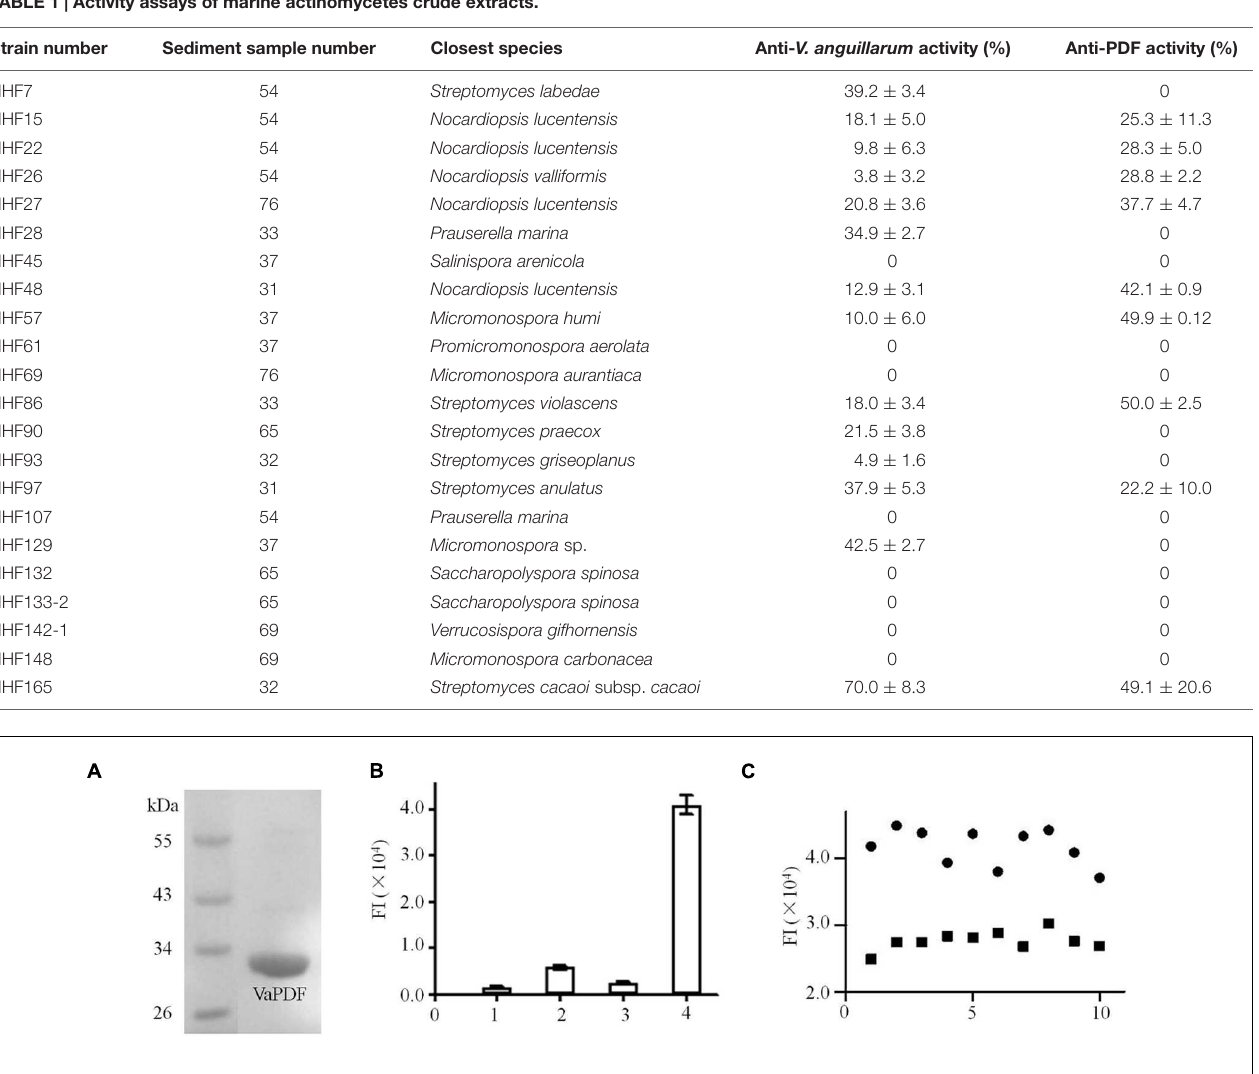
FIGURE 1 | Purification and activity assays of Vibrio anguillarum PDF (VaPDF). (A) The purified VaPDF with 6 × His tag. (B) Activity assays of purified VaPDF. 1, HEPES buffer. 2, HEPES buffer + formyl-Met-Ala-Ser. 3, HEPES buffer + VaPDF. 4, HEPES buffer + formyl-Met-Ala-Ser + VaPDF. Data are representative of three independent experiments. Error bars indicate standard deviation. (C) Validation of VaPDF assay. Fluroscence intensity of positive controls and negative controls were detected ( n = 10). Solid circle, negative control; solid square, positive